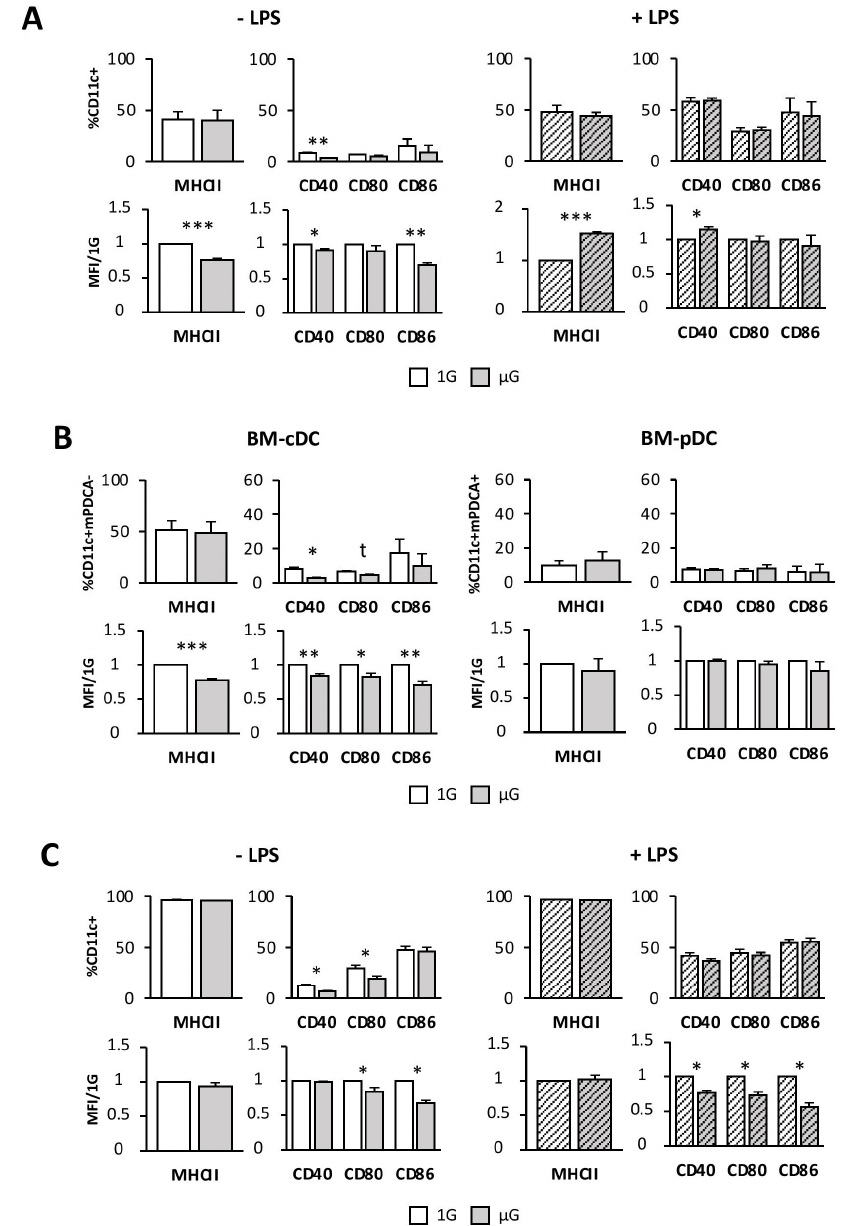
Figure 2. Simulated microgravity alters cDCs but not pDC phenotype. BMDCs differentiated for 7 days with Flt3L ( A , B ) or splenic DC ( C ) were cultured for 24 h in the absence (1G) or presence ( µ G) of simulated microgravity and with (+LPS) or without ( − LPS) LPS. Cells were then analyzed by flow cytometry for the expression levels of MHCII, CD40, CD80, and CD86 in CD11C+, CD11C+ mPDCA- (cDC) or CD11C+ mPDCA+ (pDC) populations. ( A – C ) Mean percent ± SEM of gated cells expressing MHCII, CD40, CD80, and CD86 (top panel). Mean MFI ± SEM with 1G values set as 1. Data were normalized and are expressed as fold differences relative to 1G cells (bottom panel). Data are from three ( A , B ) or four ( C ) independent experiments. T-test or Mann–Whitney test was used to reveal statistically significant differences. * p < 0.05, ** p < 0.01; *** p < 0.001, t indicates a tendency.